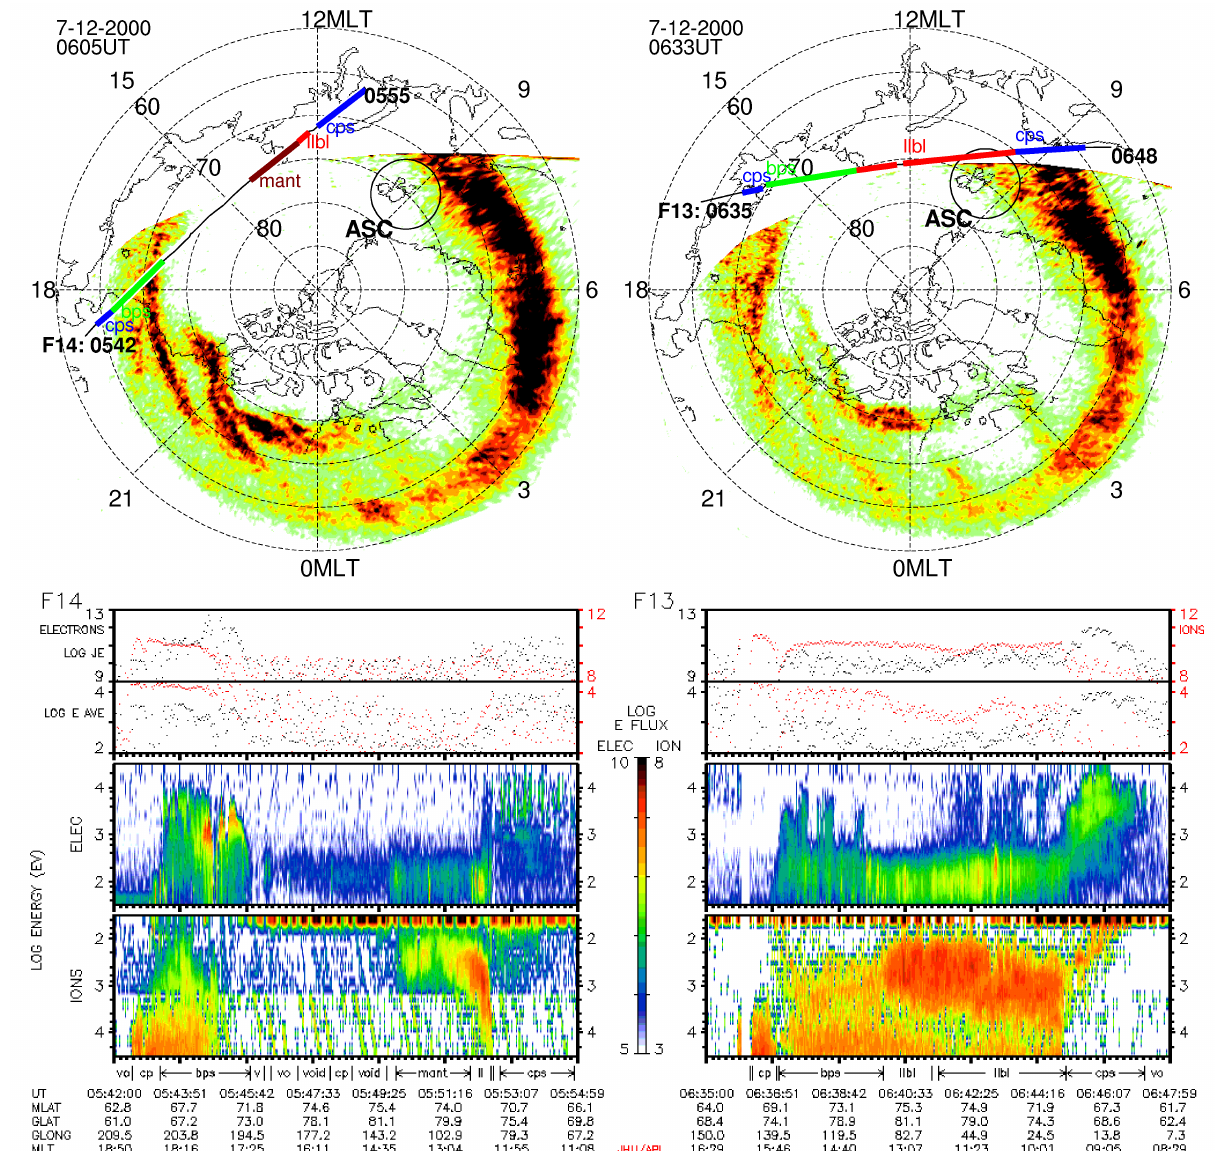
Fig. 2. Two UV frames obtained during B y -dominated (left) and strongly northward (right) IMF conditions. Trajectories of the DMSP satellites are shown on the frames, where different colors along the trajectories indicate precipitations from different magnetospheric regions. The magnetospheric boundaries were identified using algorithms of Newell et al. (1991) from the DMSP spectrograms shown in the bottom